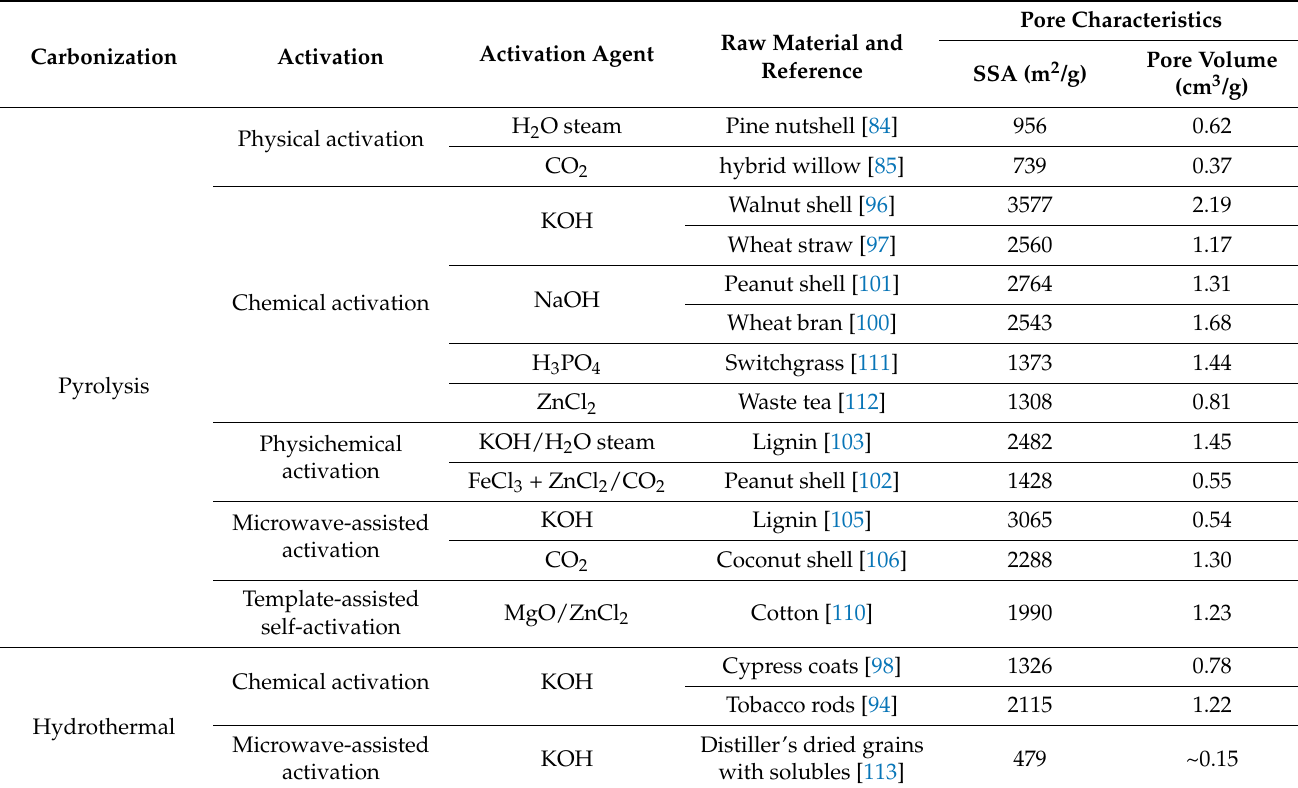
Table 2. Examples of lignocellulosic carbon prepared by different carbonization/activation methods.